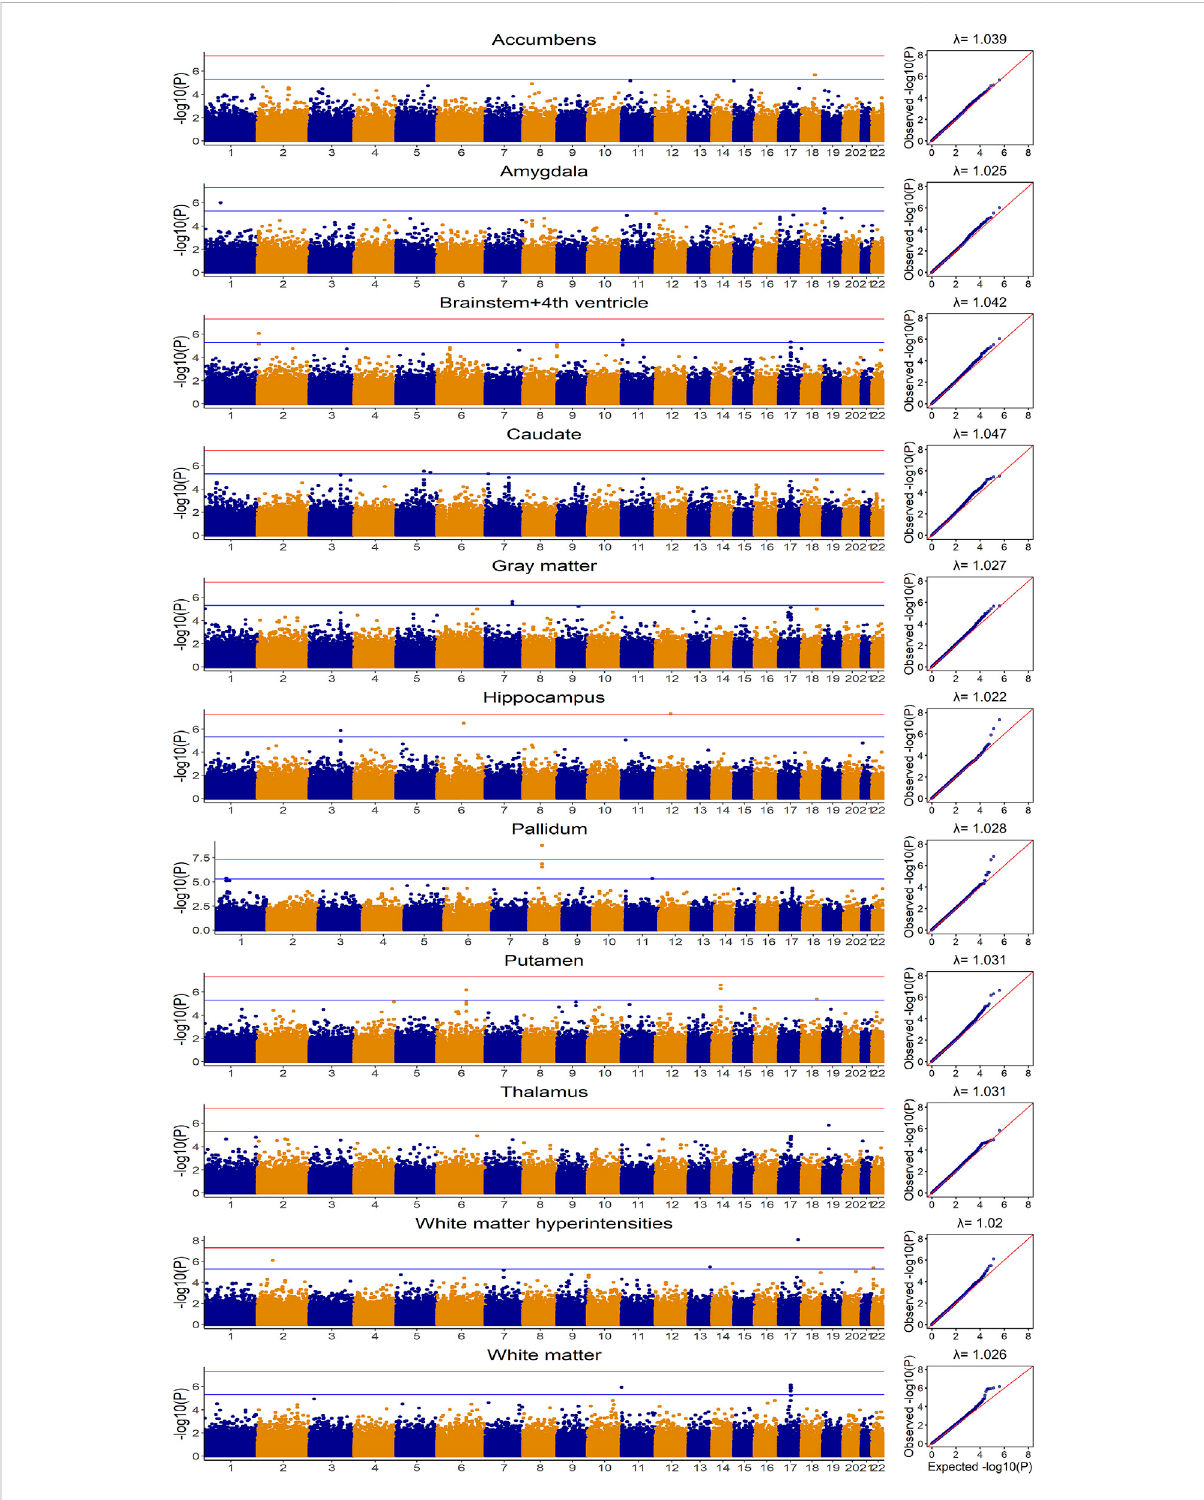
FIGURE 3 Manhattan and Quantile-Quantile plots for eleven brain imaging traits in UKB based on additive model for Genome-wide association